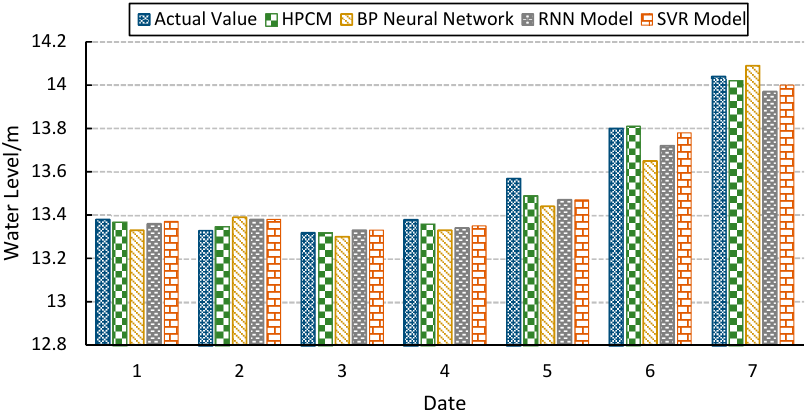
Figure 9. Predicted value of different models.